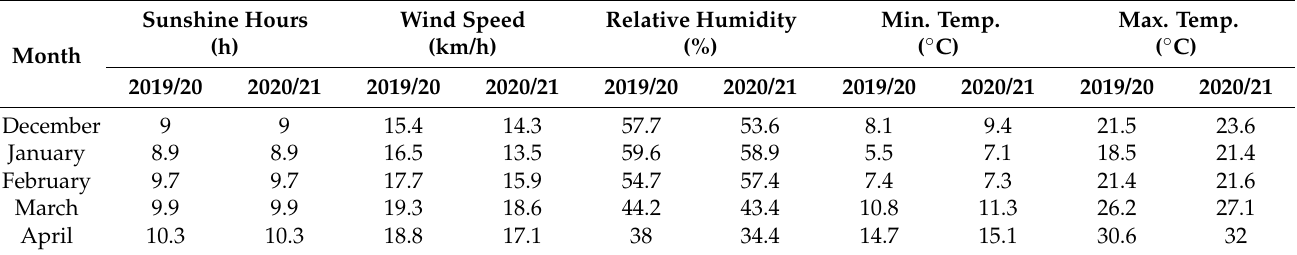
Table 1. Average monthly meteorological data for the Arab El-Awammer Research Station during the two growing seasons of 2020/2021 and 2021/2022.